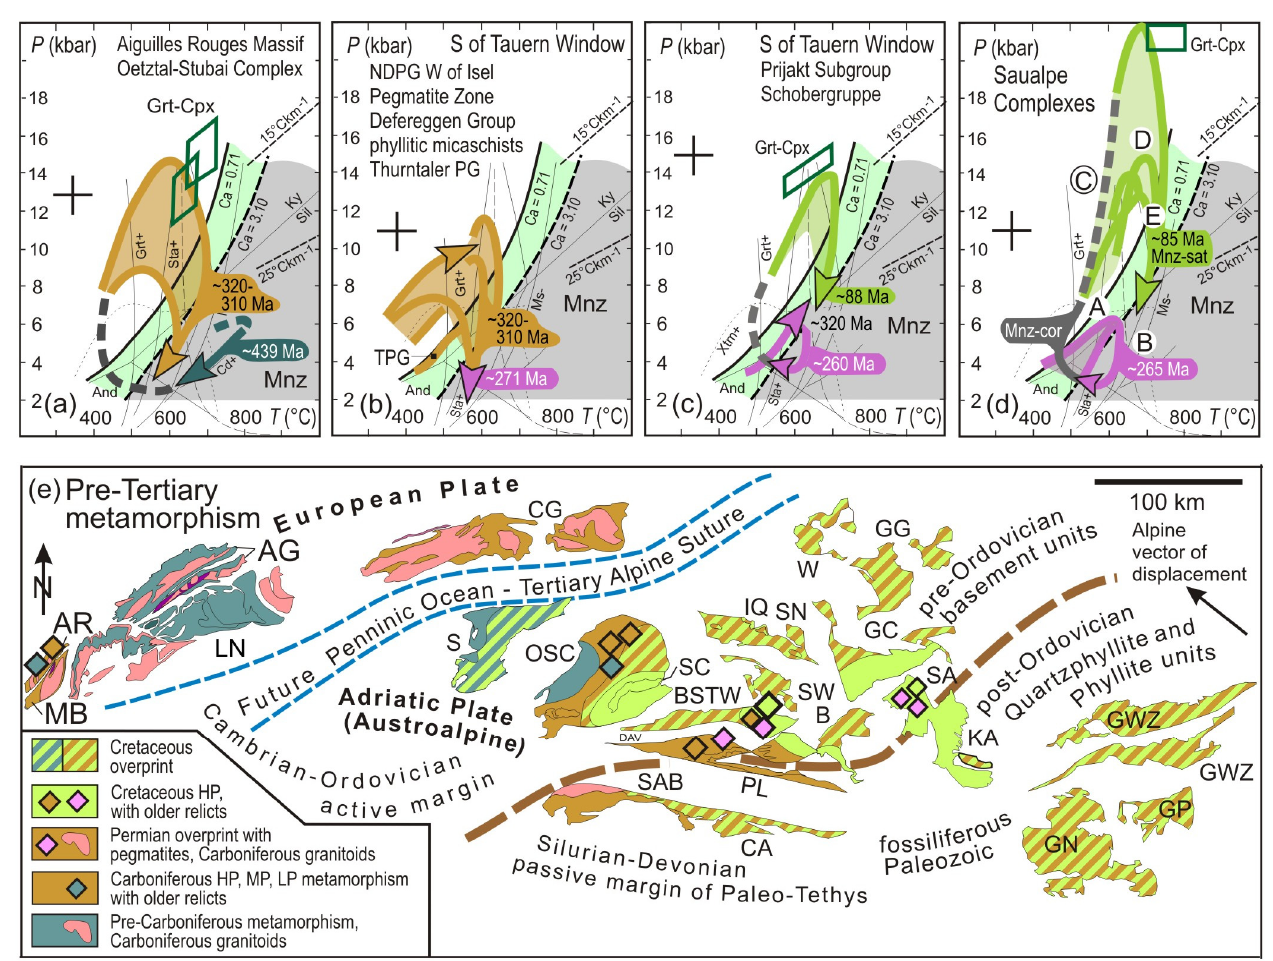
Figure 9. ( a – d ) Compilation and interpretation of P-T-time path segments in Alpine basement units from Figures 3–6. Aluminosilicates (And, Ky, Sill), cordierite-in (Cd+), muscovite-out (Ms-) and staurolite-in and -out (Sta+, Sta-) univariant lines [30]. Stability fields (green and gray) of monazite (Mnz) and allanite (Aln) at different bulk rock contents as a function of Ca wt%, and with the xenotime (Xtm) stability field [77,78]. P-T data (Grt-Cpx) from eclogites is given in green boxes. Bold cross is uncertainty of ±50 °C/±1.0 kbar on P-T estimates. Distinct parts of the P-T path segments are labelled with Ordovician-to-Silurian (dark green), Carboniferous (brown), Permian (purple) and Cretaceous (light green) monazite ages in Ma. For labelling A-E of P-T path segments in Saualpe complexes ( d ) see text. ( e ) Selected Alpine basement units in a pre-Mesozoic configuration, following mainly a palinspastic restoration. The main Tertiary Alpine displacement vector of basement units is SE-NW. Basement units belong to a Cambrian-Ordovician active margin and a Silurian-Devonian passive margin setting [3]. The assignment of basement units to pre-Tertiary metamorphic periods follows the map of metamorphism in the Alps [2]. Locations reported here are marked with colors of monazite age populations. Abbreviations of basement units and major tectonic lines: AG Aar-Gotthard; AR Aiguilles Rouges; B Bundschuh; BSTW Basement to the south of Tauern Window; CA Carnic Alps; CG Central Gneisses; DAV Defereggen-Antholz-Vals Line; GC Gleinalm Complex; GG Grobgneis Complex; GN Gurktal nappes; GP Palaeozoic of Graz; GWZ Greywacke Zone; IQ Innsbruck Quartzphyllite; KA Koralpe; LN Lepontine Nappes; MB Mont Blanc; OSC Oetztal-Stubai Complex; PL Peri- adriatic Lineament; S Silvretta; SA Saualpe; SAB South Alpine Basement; SC Schneeberg Complex; SP Speik Complex with Kraubath ophiolite; TPG Thurntaler Phyllite Group; TW Tauern Window; W Wechsel Gneiss Complex.